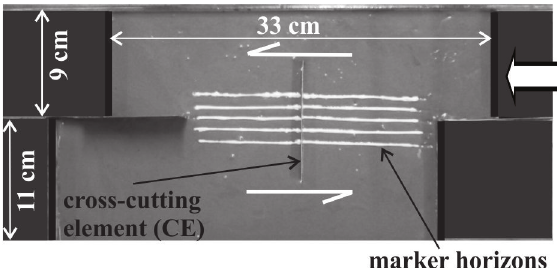
Figure 2 - A photograph of the initial experimental setup in plan view (model CIS90). The silicone is grey, and the front walls are black. The thick arrow indicates the direction of the movement of the upper half of the box, and the thin double arrows indicate the bulk simple shear.